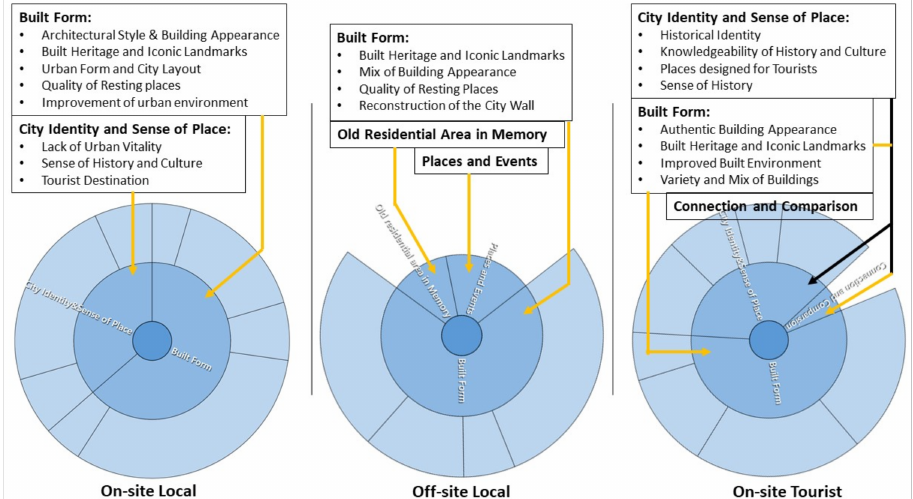
Figure 5. Results and categories—impression and image.